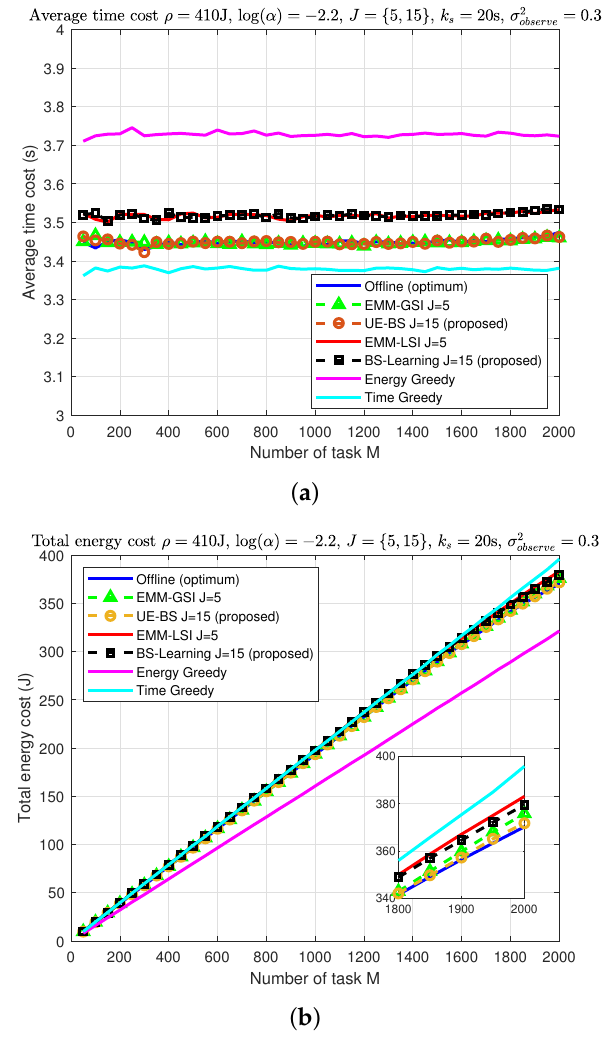
Figure 4. Performance evaluation of algorithms ( ρ = 410 J, log ( α ) = − 2.2, J = { 5,15 } , k s = 20 s, = 0.3): ( a ) average time cost; ( b ) total energy σ 2 observe